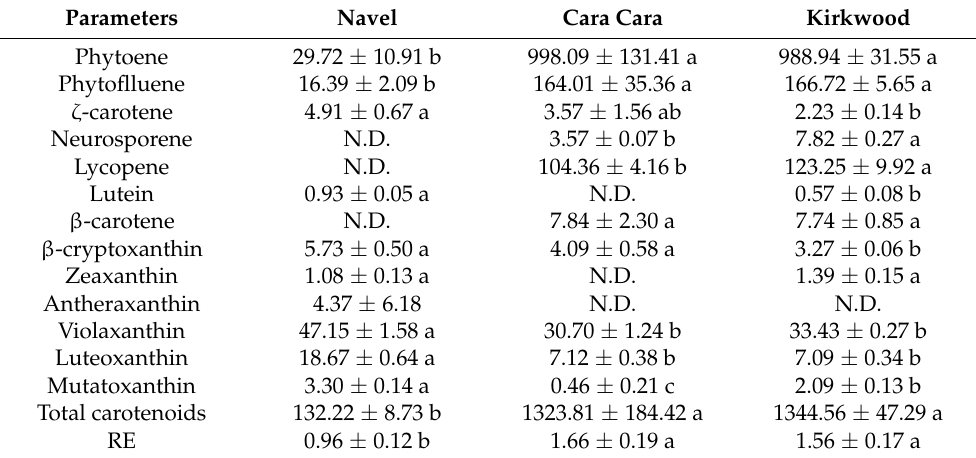
one-way ANOVA ( p < 0.05). N.D: not detected. R.E: retinol equivalents.